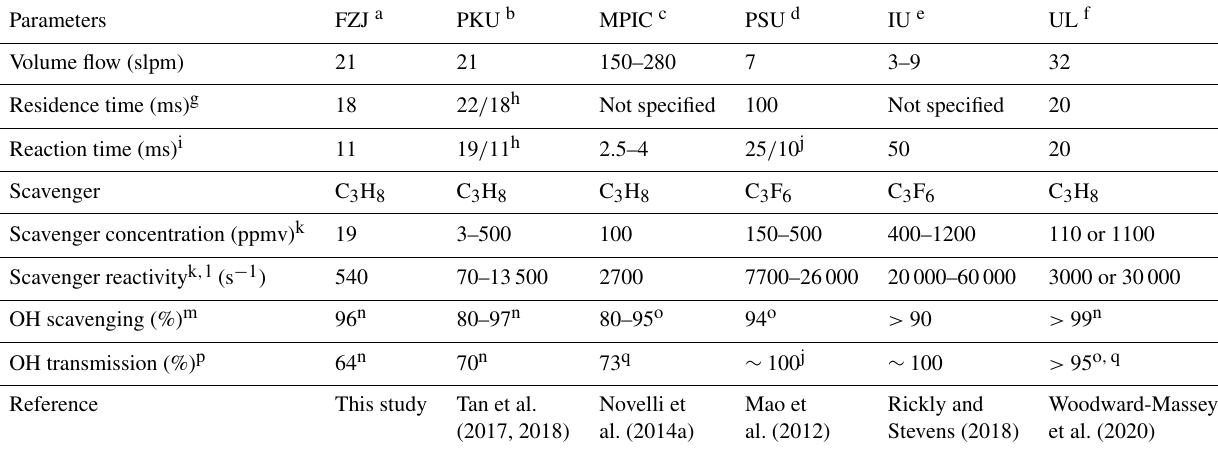
Table 1. Characteristics of chemical modulation reactors for different OH LIF instruments.